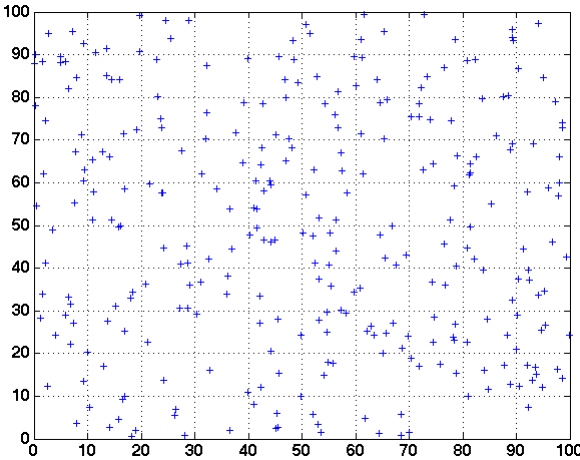
Figure 7. Sensing grid of the network at the initial